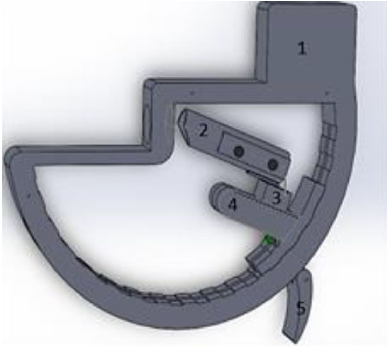
Figure 2. Experimental system of effort measurements. 1—system body; 2—rigid cylindrical tube; 3—sensor mounting; 4—T-piece; 5—hanging flange.